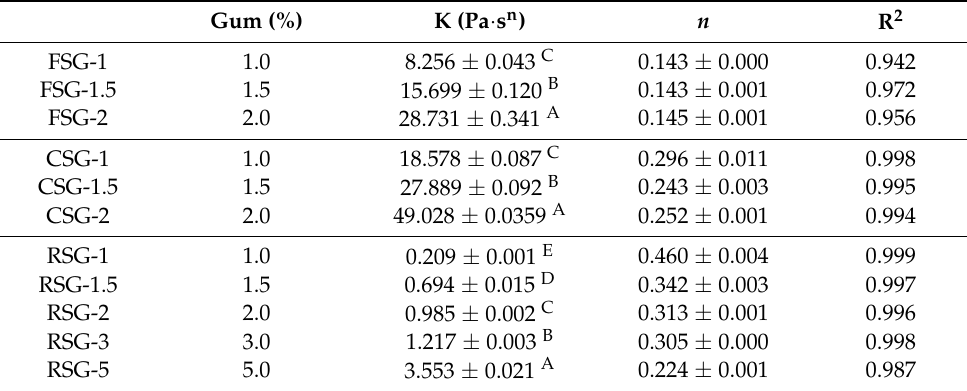
Table 2. Steady shear power-law parameters of gum